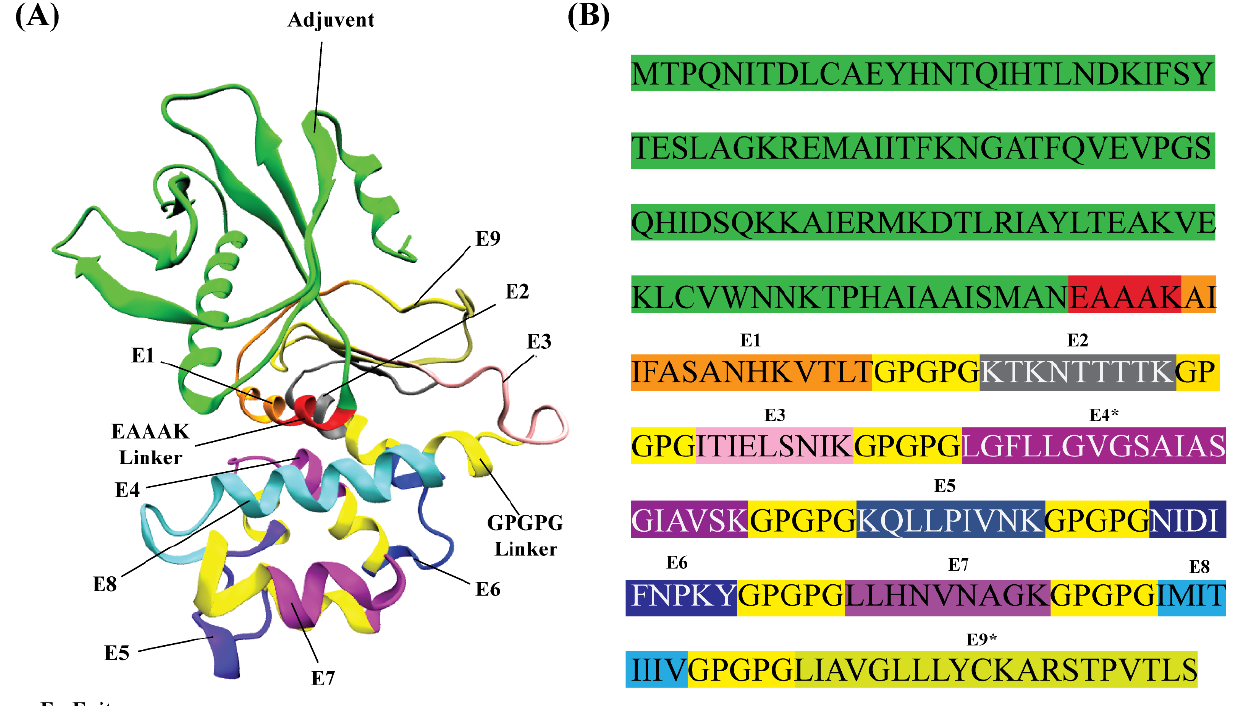
Figure 4. Constructed vaccine for RSV in the present study. ( A ) Modeled three-dimensional structure of vaccine construct. ( B ) Complete amino acid sequence of the vaccine construct. An adjuvant, cholera toxin subunit B, was placed towards the N-terminal of the construct. Specialized linkers (EAAAK and GPGPG) were added to separate the prioritized epitopes. Epitopes 4 and 9 are the merged CD4+ T-cell and CD8+ T-cell epitopes. These two epitopes are indicated by E4* and E9* (stars are added for easy identification).